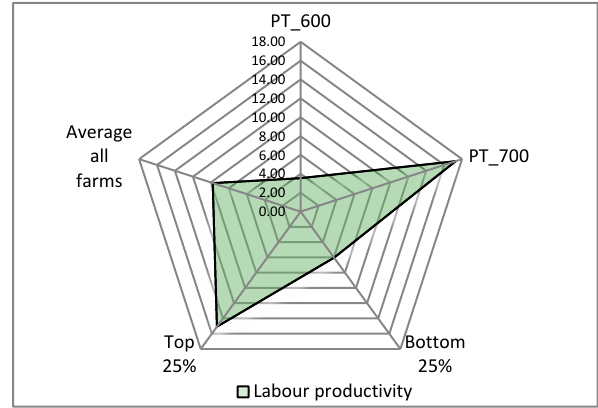
Figure 10. Physical productivity of labor (kg LW/h). Source: model results.